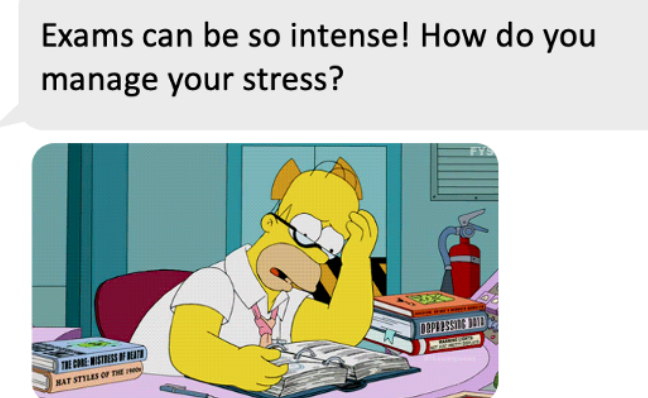
Figure 1. Sample question (friendly tone, open-ended, with